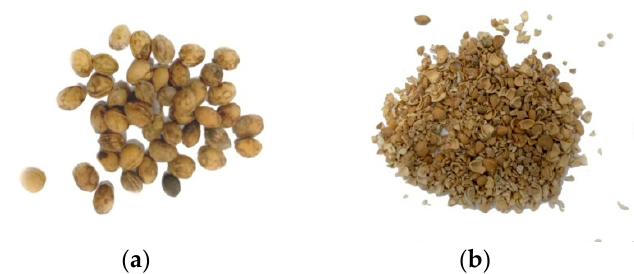
Figure 1. Cherry stones used for the granulation process: ( a ) in the form in which they left the production plant;( b ) in a crumbled form.